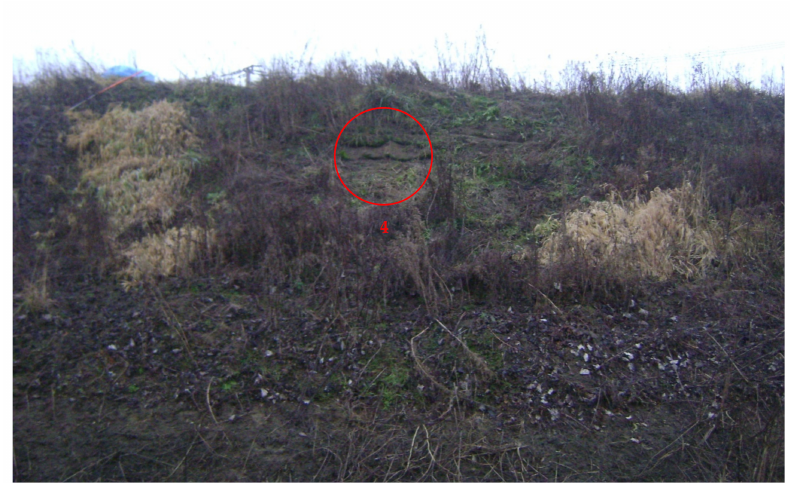
Figure 3. Closer view of location 4 of the protected slope in Nieboczowy (state of slope on 18 January 2020). In the circle: exposed recycled natural and synthetic fibers (RNSF ropes); to the right of the circle: wool rope.